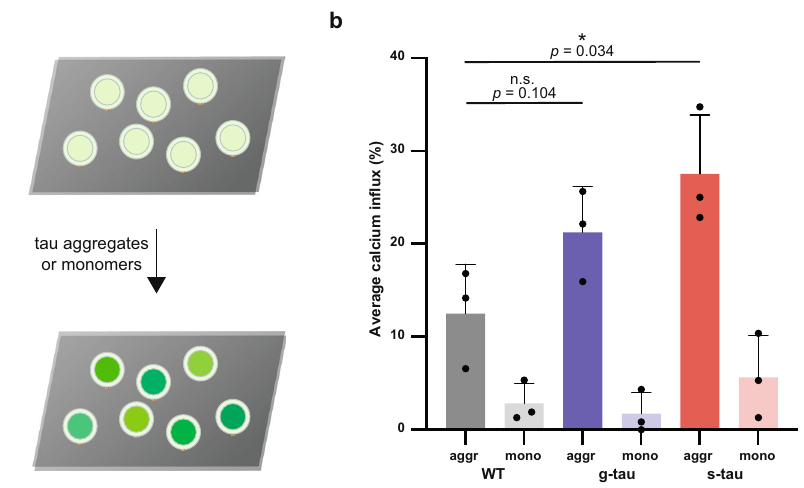
Fig. 3 Hyperphosphorylated tau amorphous aggregates disrupt membrane integrity more effectively than WT fi brillar aggregates. a The ability to disrupt membrane integrity, an important aspect that explains the toxicity of protein aggregates, was quanti fi ed by calcium in fl ux caused by each tau species. The percentage of Ca 2 + in fl ux was normalized by the maximum Ca 2 + in fl ux induced by ionomycin. b Our results from the liposomal assay revealed that WT tau aggregates caused 12 ± 2% calcium in fl ux, g-tau aggregates elicited 21 ± 5% calcium in fl ux, and s-tau aggregates induced 28 ± 6% calcium in fl ux. All of the monomeric controls caused less calcium in fl ux than their corresponding aggregate samples. Hence, s-tau aggregates can better permeabilize synthetic lipid bilayer than WT aggregates (data are presented as mean values± s.d. of n = 3 for each tau species, the P -values are based on unpaired two-sided Student ’ s t -test: * p < 0.05, n.s. non-signi fi cant). Source data are provided as a Source Data fi